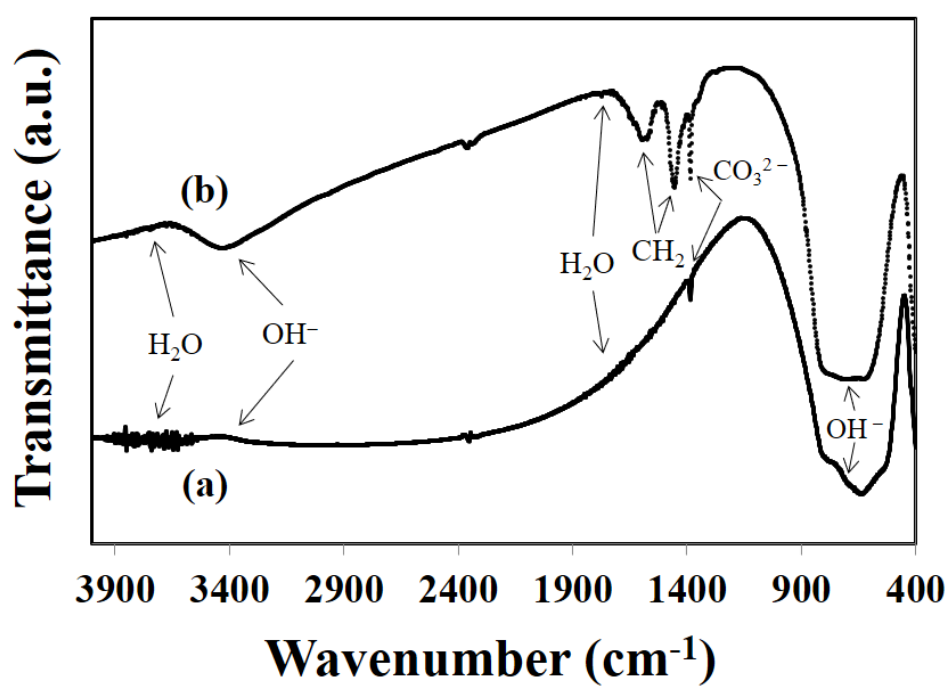
Figure 9. FT-IR spectra of KNN particles synthesized by glycothermal treatment in different synthesis conditions: ( a ) pure hydrothermal and ( b ) pure glycothermal at 200 °C for 12 h.